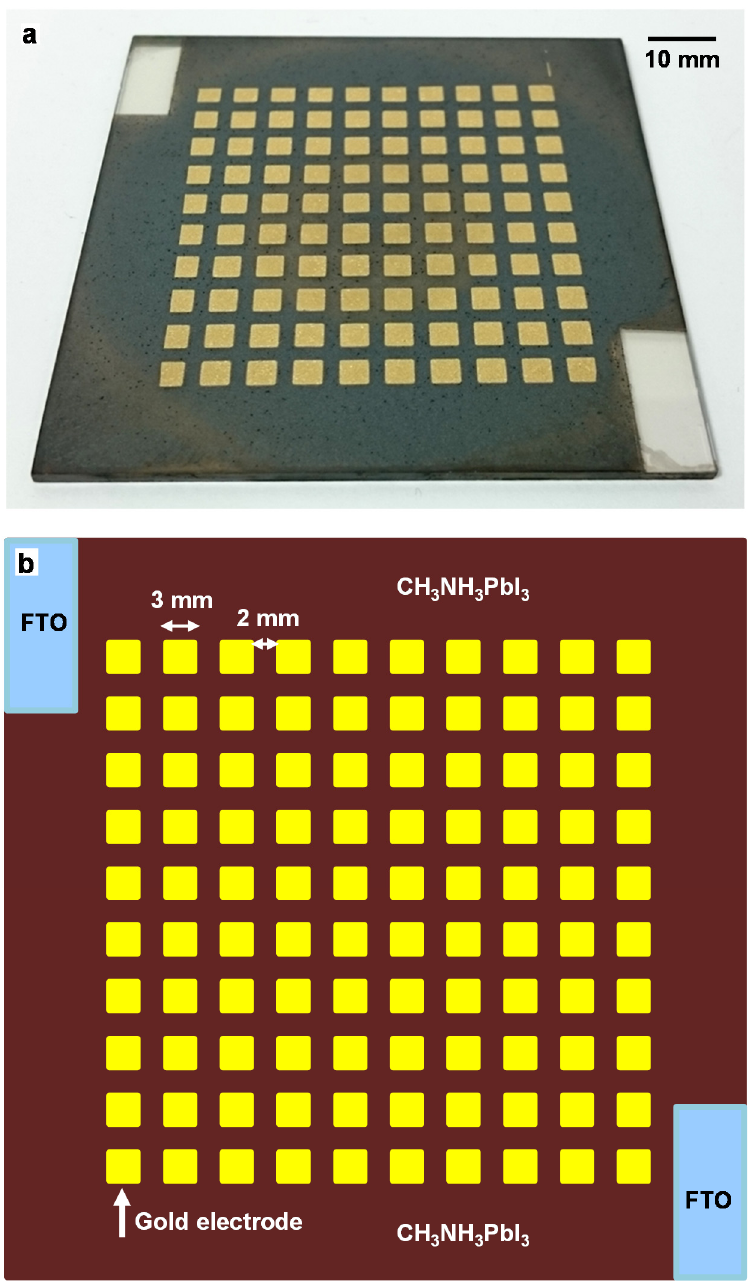
Figure 2. ( a ) Photograph of perovskite solar cell measuring 70 mm × 70 mm; ( b ) Schematic illustration of arrangement of Au electrodes on the